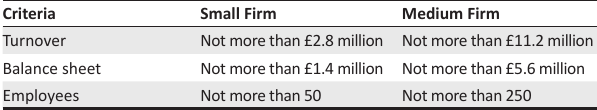
TABLE 3: United Kingdom’s definition of small enterprises.